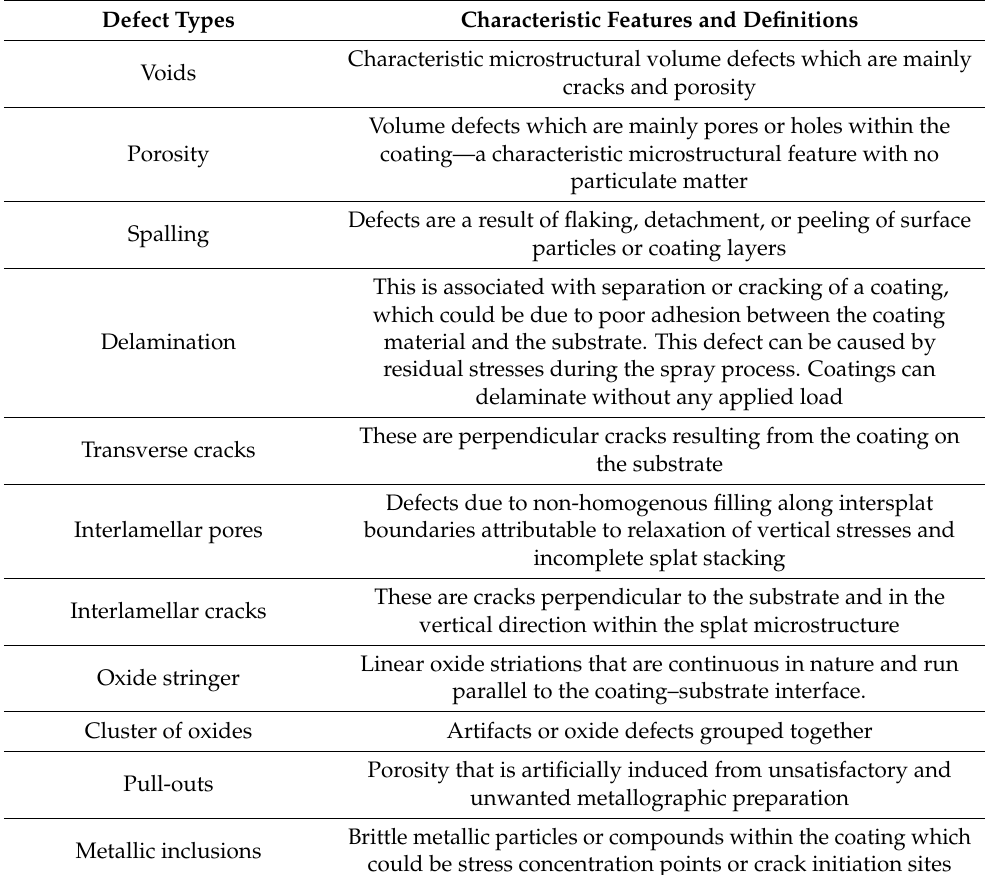
Table 10. Typical defects and characteristic features associated with thermal spray processes. Reprinted/adapted with permission from Ref. [29]. Copyright 2023, Taylor and